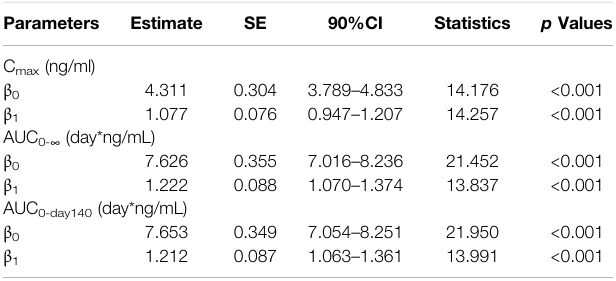
TABLE5| C max ,AUC 0-Day140 ,AUC 0- ∞ ,anddoserelationshipforsingleinjectionof 18 – 120 mg LY06006 (based on 90%CI). Parameters